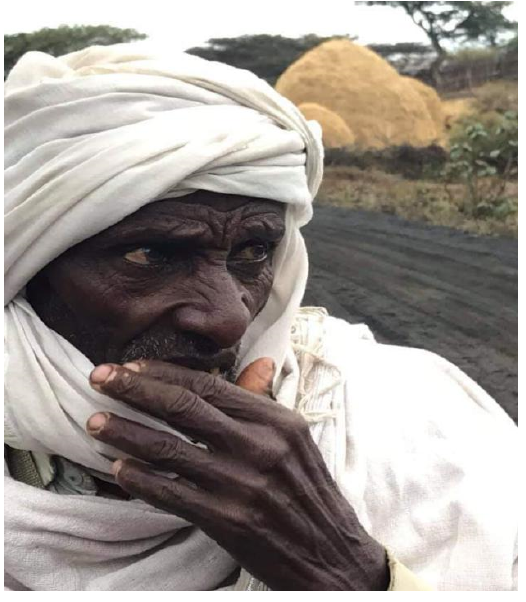
Figure 2. Ahmad Gammada (Inft.). Balaale. 27 January 2020. Photo, Author.